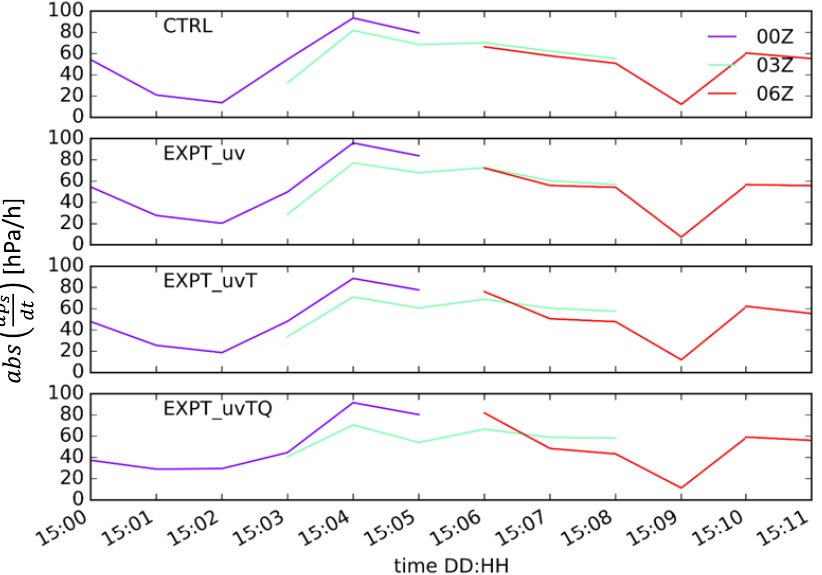
(cid:16)(cid:12) (cid:12) (cid:12)(cid:17) dP msl (cid:12) (cid:12) , averaged horizon- (cid:12) dt |) , averaged horizon- 𝑑𝑡